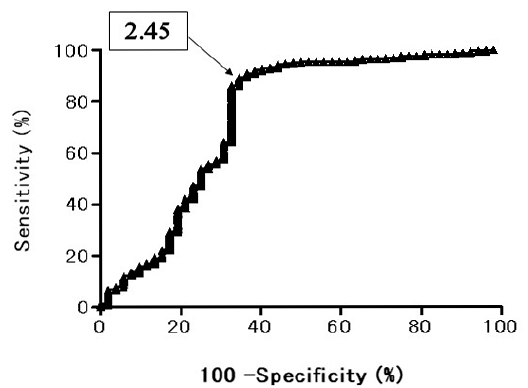
Figure 2. Receiver operating characteristic (ROC) curve shows the diagnostic performance of T2 contrast ratio (T2 CR) for distinguishing BPNM from lung cancer. Area under the ROC curve 74.3%. T2 CR = 2.45, sensitivity 89.5%, specificity 65.4%.